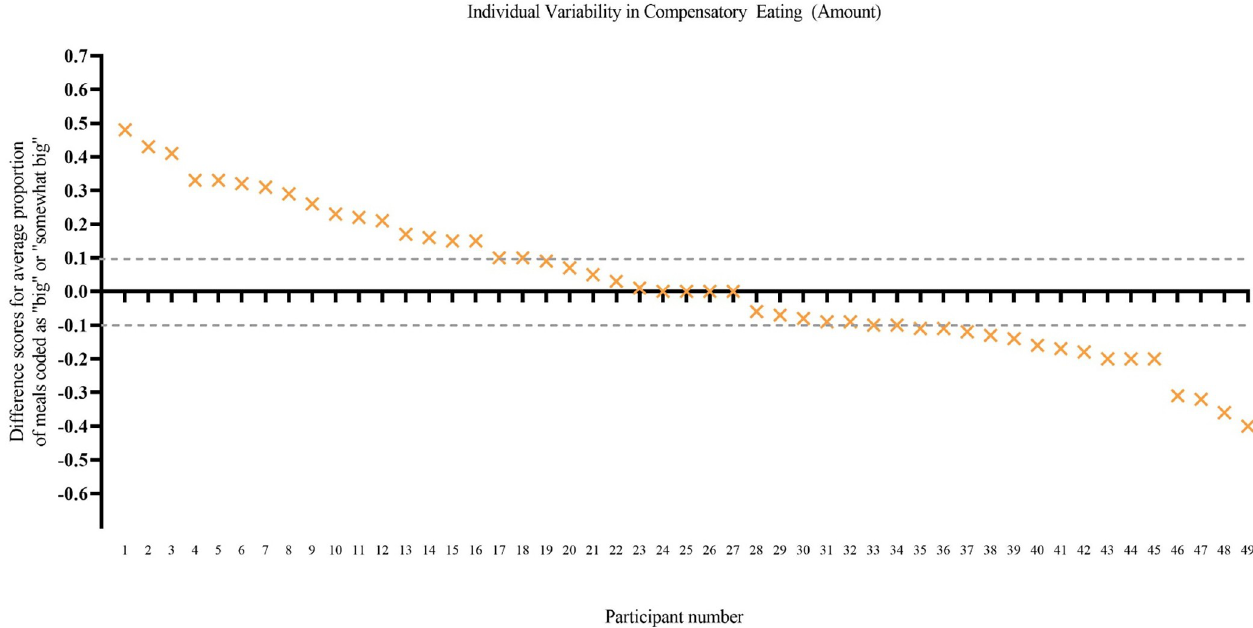
Fig 3. Individual variability in patterns of eating—Amount (Study 2). The y axis shows a difference score for each participant: the proportion of post- exercise meals that were big or somewhat big minus the proportion of random meals that were big or somewhat big. A positive score indicates that, on average, the participant consumed a greater proportion of big meals post exercise than at random meals (i.e., compensatory eating). Dotted lines indicate the boundaries ( ± 0.10) used to mark an eating pattern that was indifferent to exercise (similar proportion of big meals after exercise and at random meals). Participant scores are ordered in descending order from most compensatory eating to least compensatory